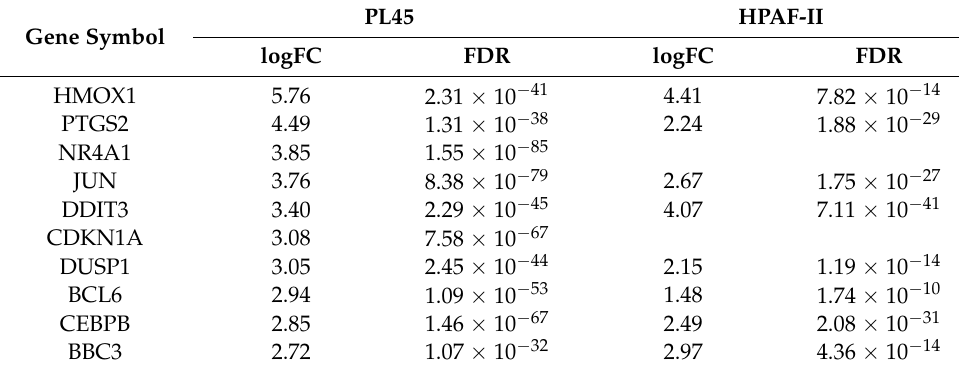
Table 1. Upregulation of apoptosis-related genes in PL45 and HAPF-II cells following the treatment with CSE (FDR-adjusted q-value <